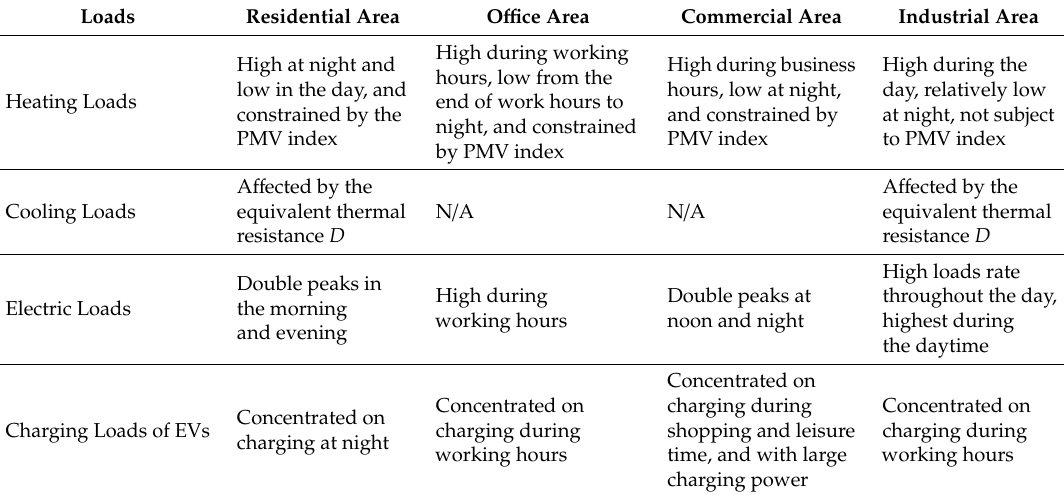
Table 3. Comparisons of load characteristics of multiple functional